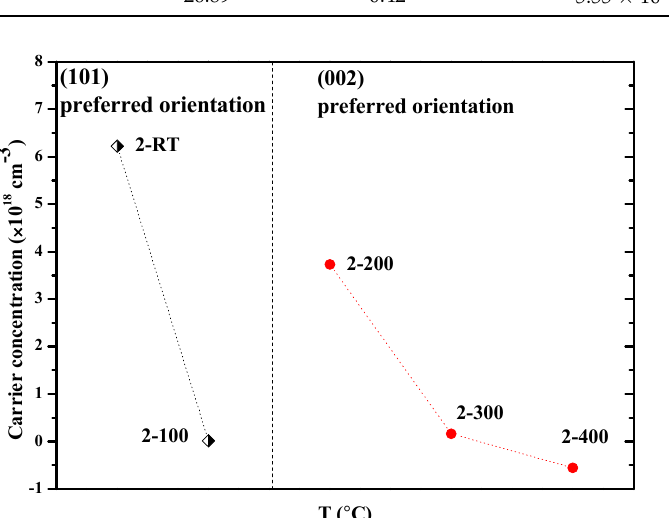
Figure 4. Carrier concentration for the ZnO:N films as a function of oxidizing temperature (T). Samples are classified by their crystal preferential orientation.